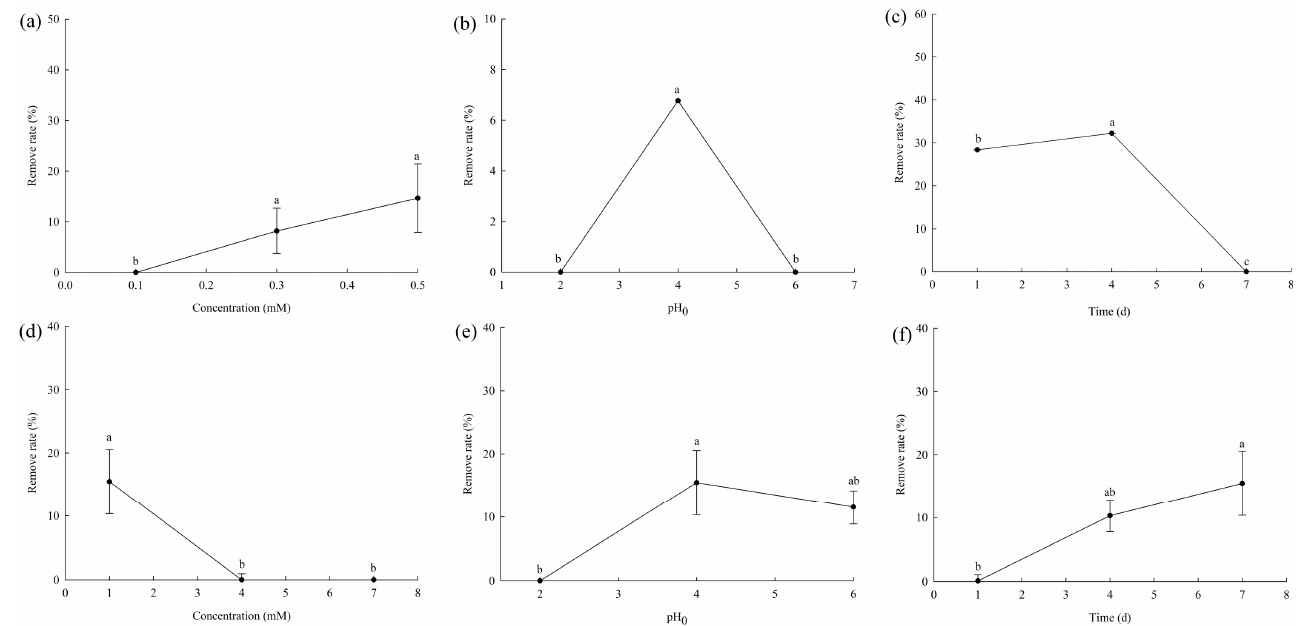
Figure 7. Effects of different factors on the remove rate of XK10 in the adsorption process. ( a ) Initial concentration for Cd adsorption; ( b ) Initial pH 0 for Cd adsorption; ( c ) Adsorption time for Cd adsorption; ( d ) Initial concentration for Sb adsorption; ( e ) Initial pH 0 for Sb adsorption; ( f ) Adsorption time for Sb adsorption. Results are expressed as mean ± SD of three replicates. Different letters indicate significant differences between the same indicators ( p < 0.05).